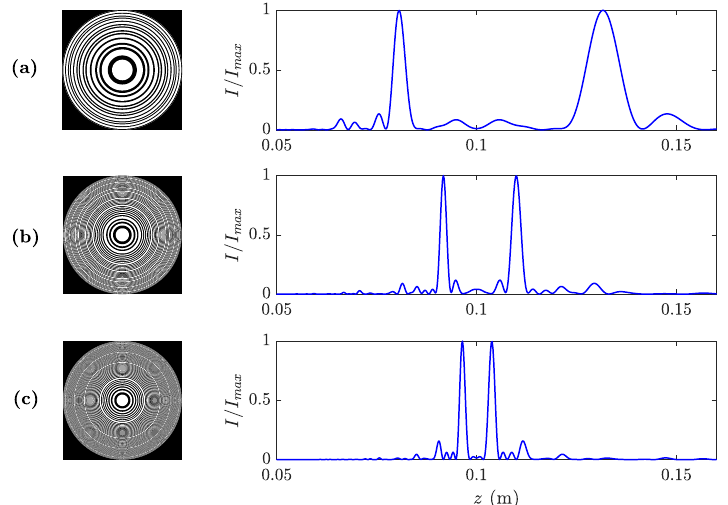
Figure 2. Focusing profile of a lens with m = 2, j = 8, z 0 = 0.3 m, and λ = 0.3 mm as a function of ( a ) the normalized axial coordinate and ( b ) the denormalized axial coordinate.